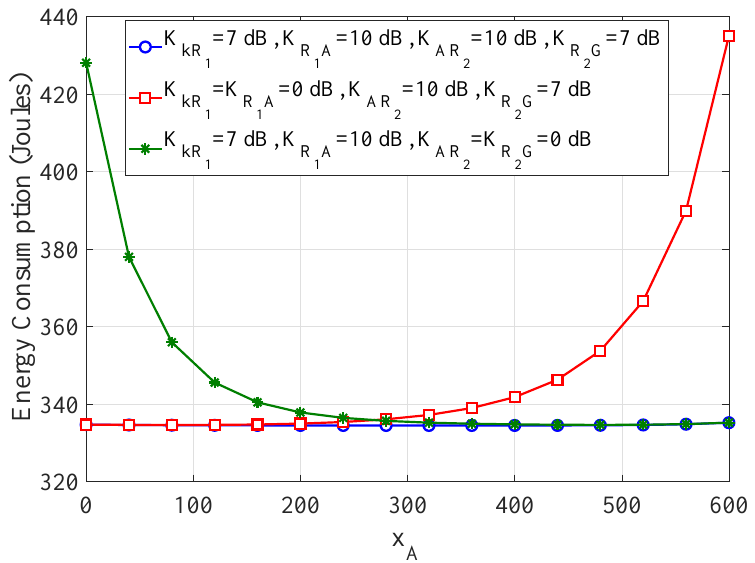
Figure 7. The WTEC as a function of the movement of ARSU along the x -axis for different values of the Rician factors K kR